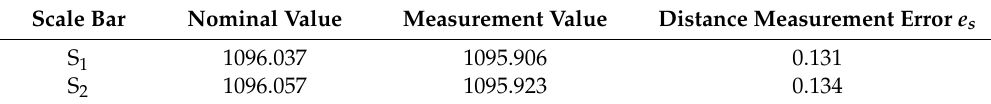
Table 5. The average distance measurement errors of scale bars (Unit: mm)